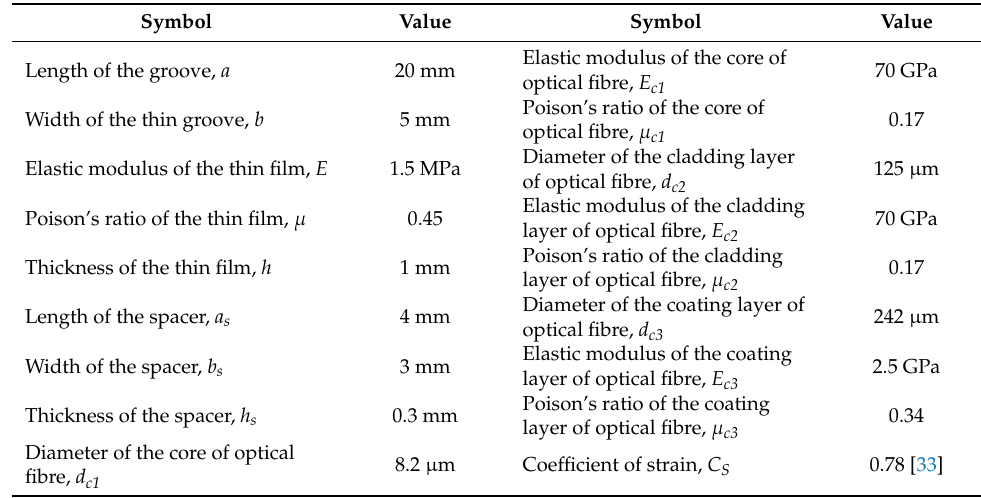
Table 1. Parameters utilized in